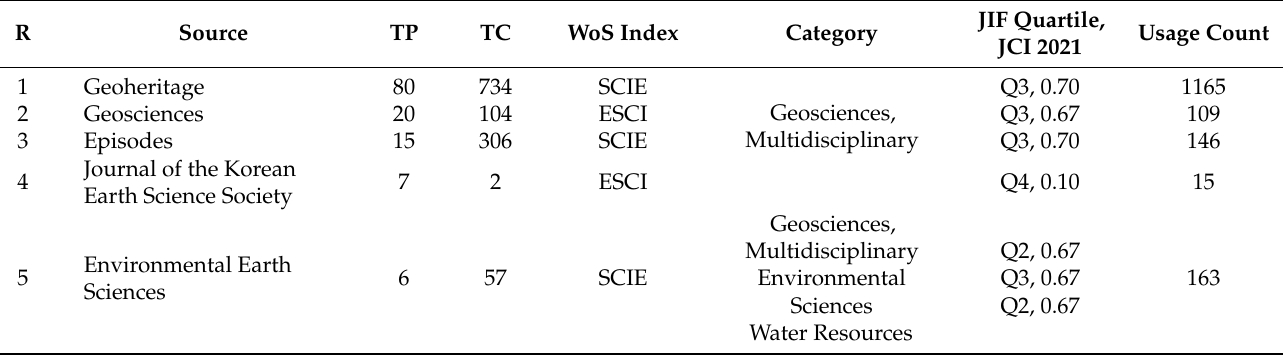
Table 5. Top 9 journals per number of